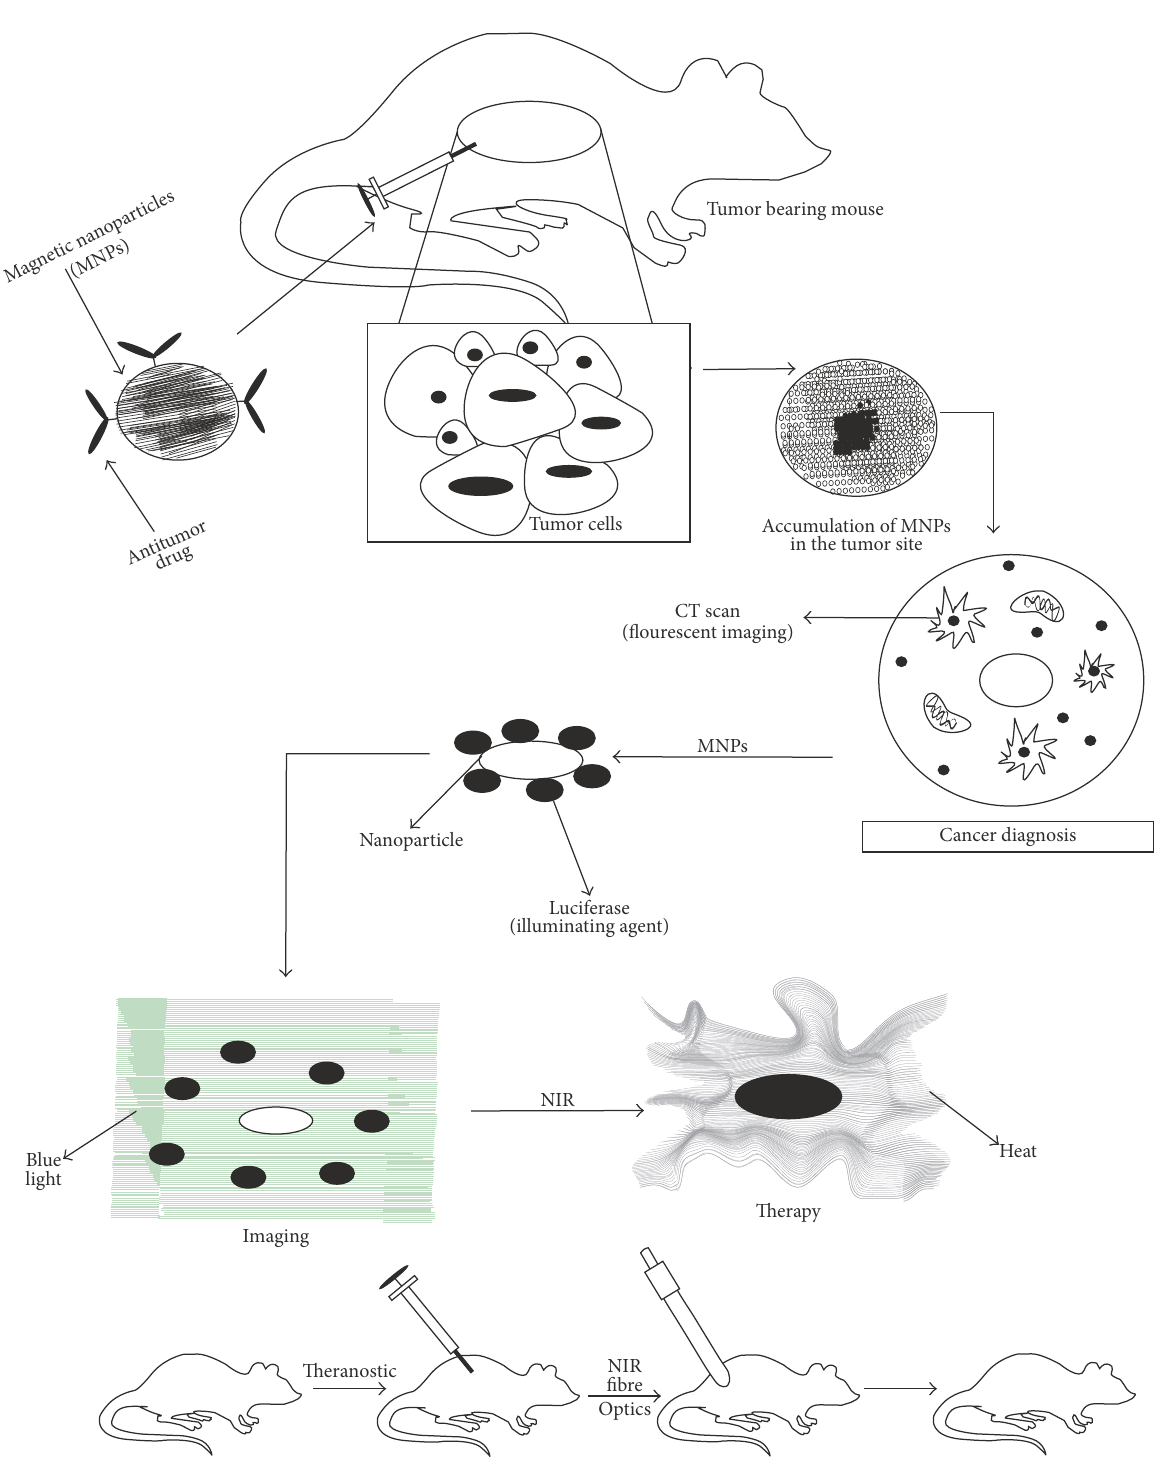
Figure 1: Schematic illustration of diagnosis by magnetic nanoparticles-guided cancer therapy. The recognition of tumor cells is conjugated withhyperthermicnanoparticlesandinsertedinvivo.InalbinoC57BL/6mice,byintraperitonealinjection,ourtheranosticapproachisableto recognize the accumulated nanoparticles at the tumor region causing significant infiltration of T-cells and macrophages creating angiogenesis process in the tumor cells causing a decline in tumor dimensions. The apoptotic rate is improved and optimal treatment is obtained in vivo in the albino rat model which is treated with MNPs through the mediation of illuminating